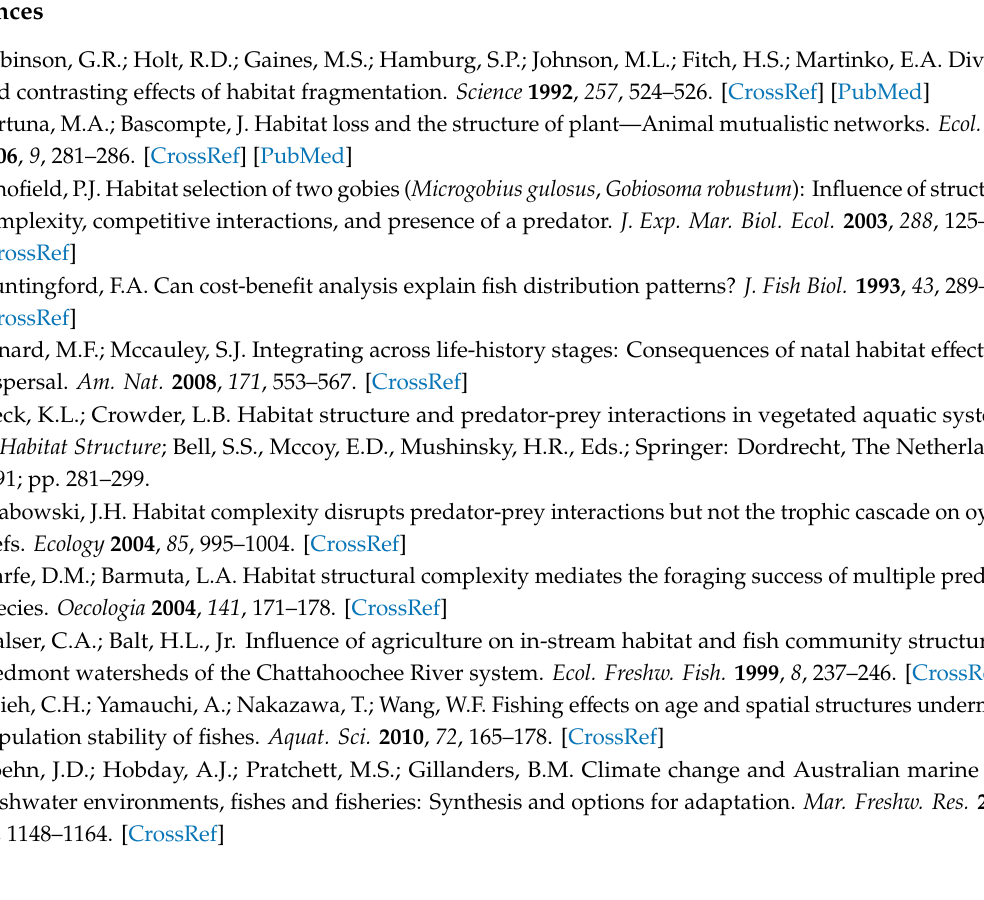
Table S1: Fish species listed in 21 study